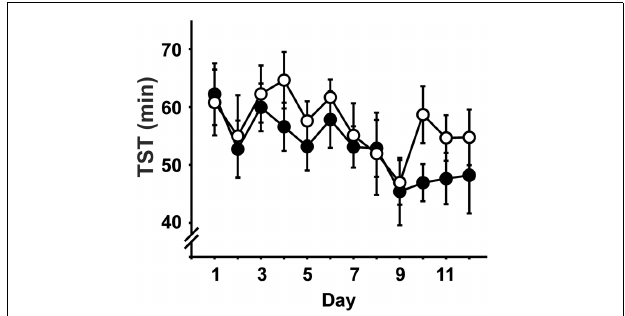
FIGURE 2 | Total sleep time (TST; mean ± s.e.m.) across the daily 2h-recording period in minutes. • Represent STIM condition, ◦ represent SHAM condition. There were no differences between the conditions, but TST decreased over experimental